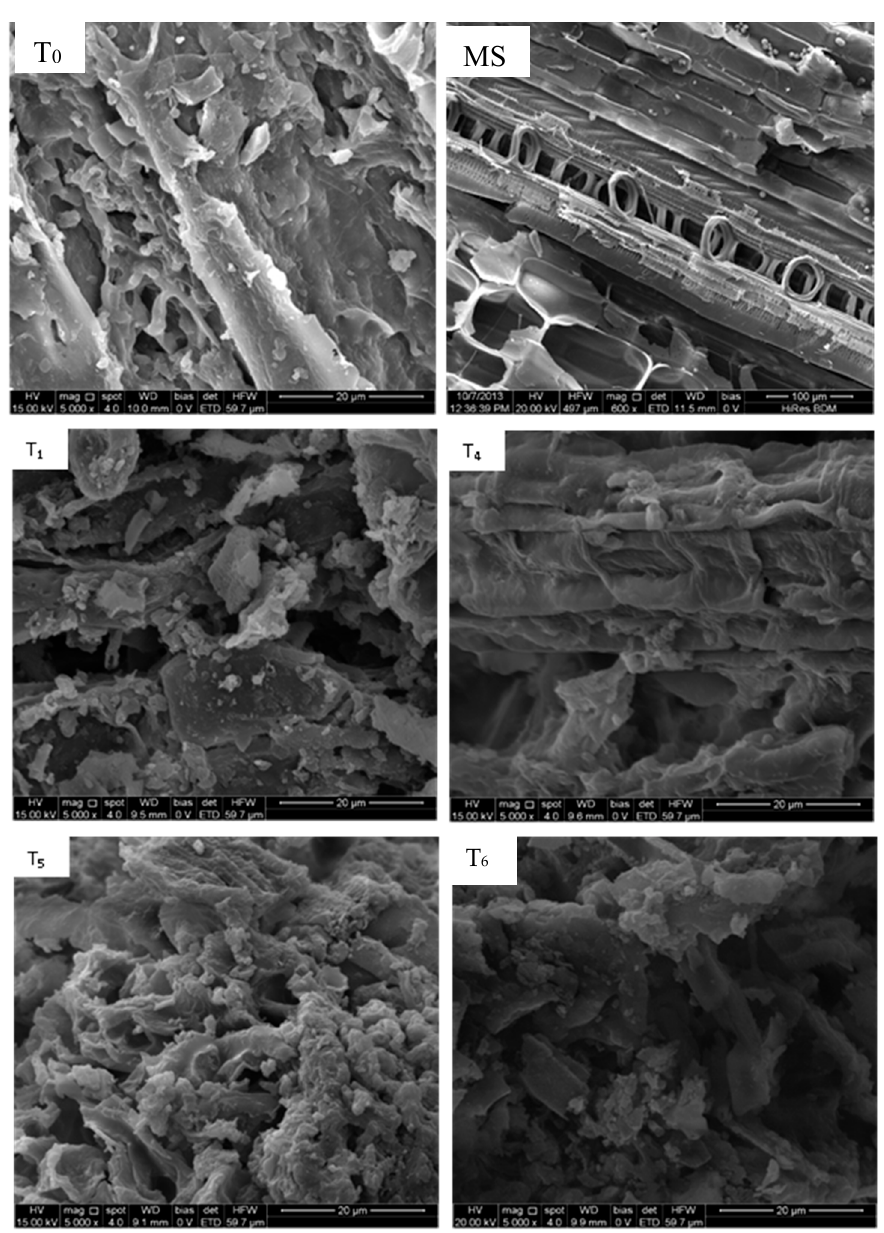
Figure 3. Scanning electron microscope (SEM) of untreated and carbonized samples (T 0 : untreated